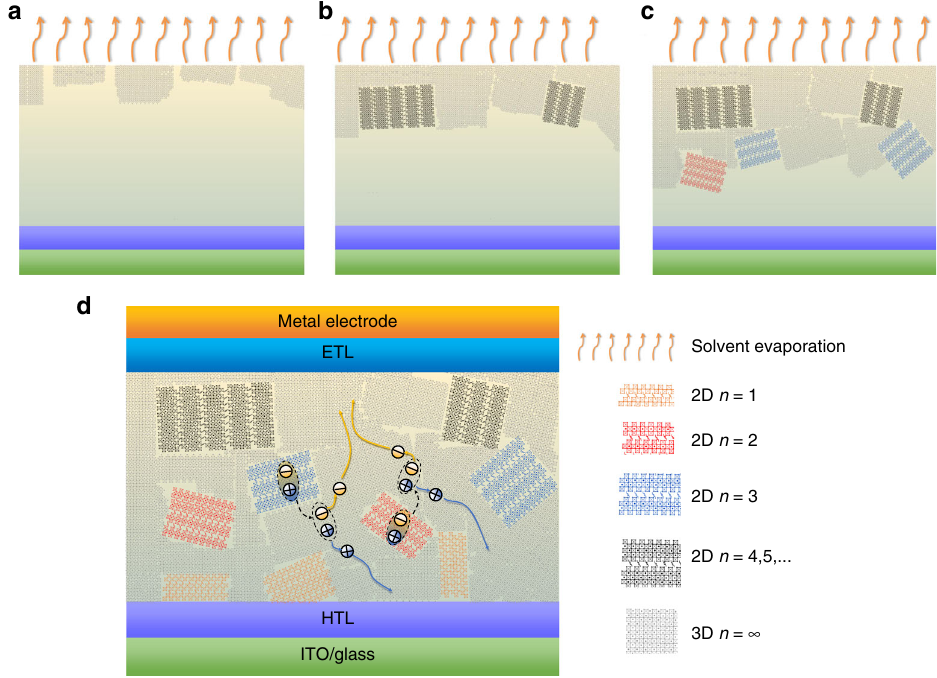
Fig. 6 Growth kinetics, morphology and device operation mechanism model. a – c The growth kinetics and morphology model. d The device structure is indium tin oxide (ITO)/hole transport layer (HTL)/layered perovskite fi lm/electron transport layer (ETL)/metal